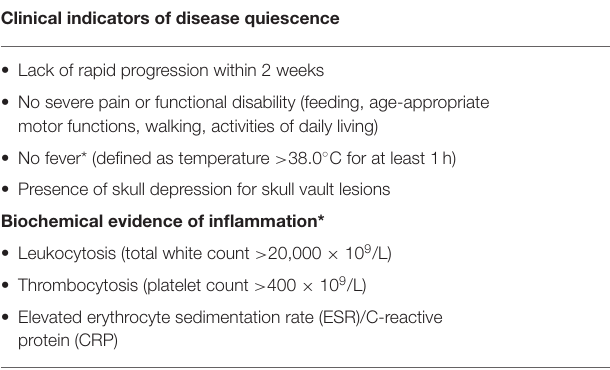
TABLE 1 | Indicators of disease quiescence in single-system